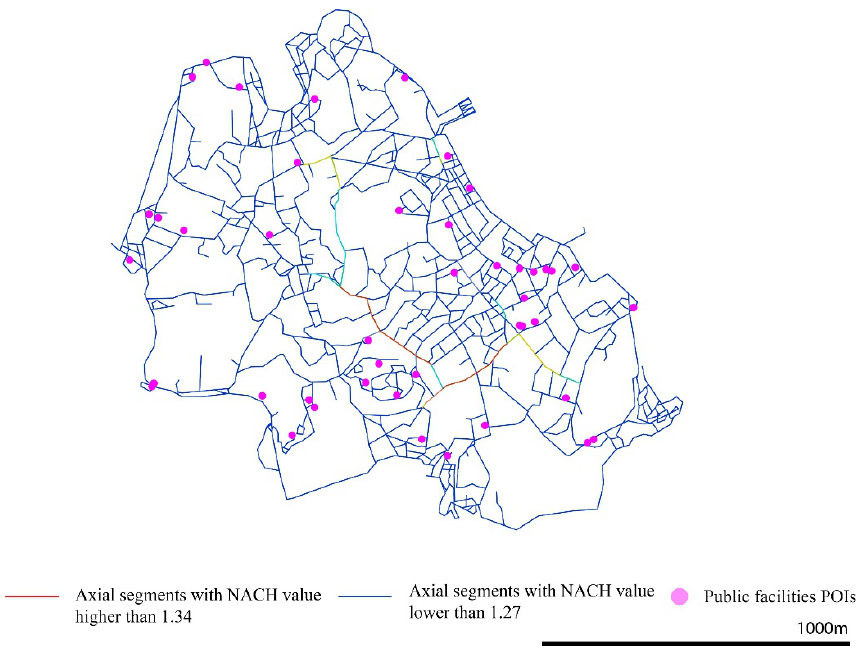
Figure 16. The public facilities POIs in Kulangsu.